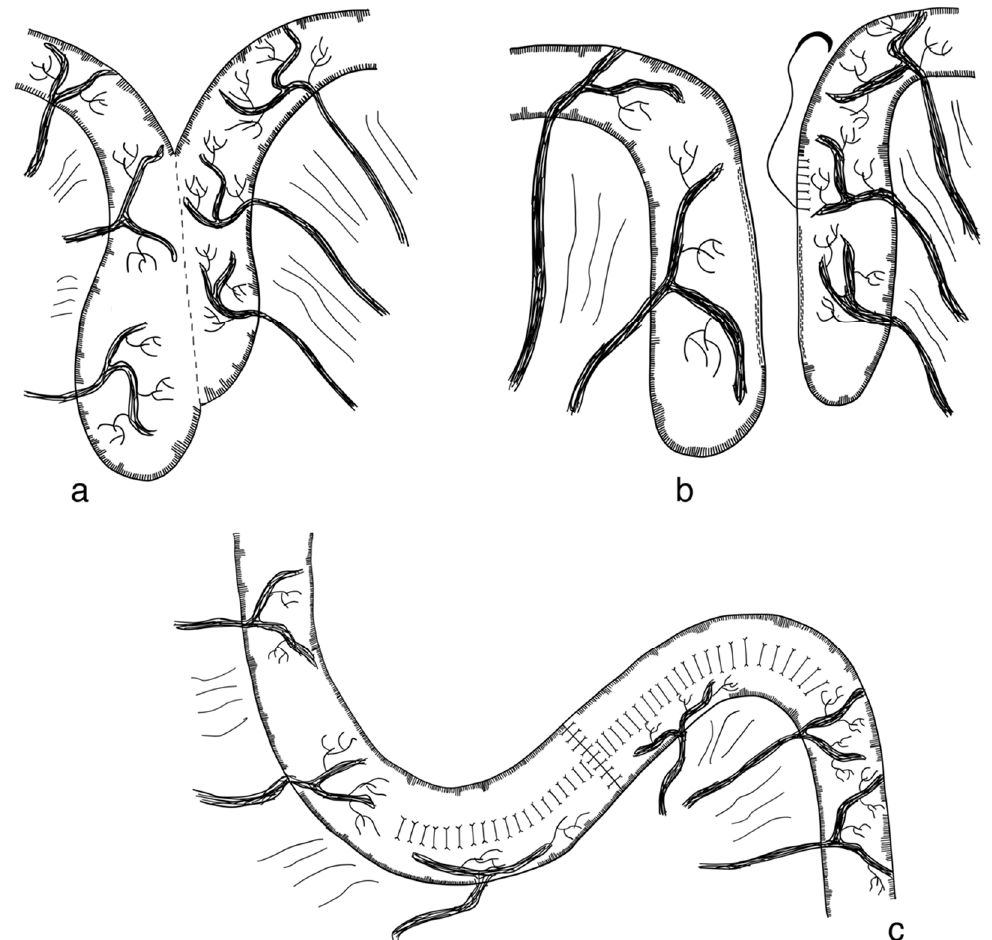
Figure 16. ( a ) Blunt division of the dilated side-to-side anastomosis. ( b ) Establishment of two blind loops of the small intestine, ( c ) which are then connected in an end-to-end isoperistaltic manner. Cruz [178].